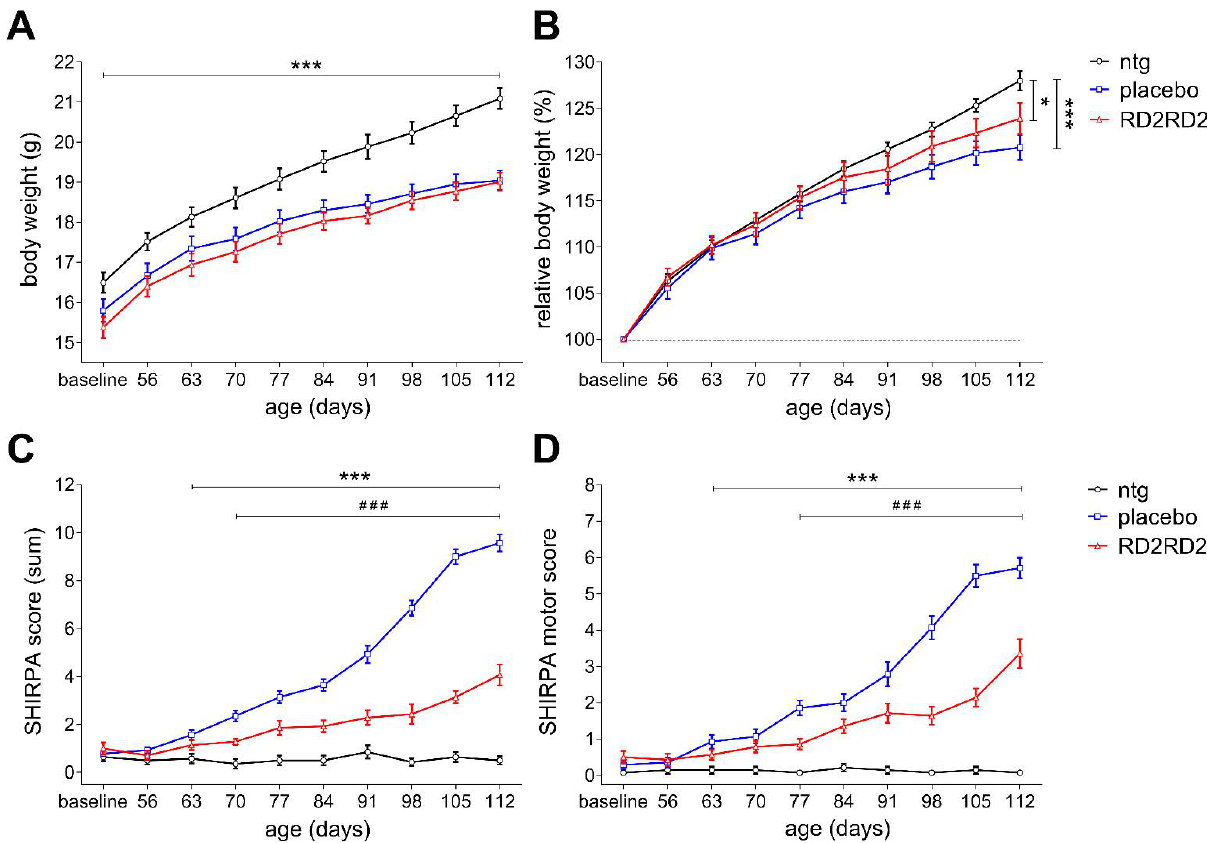
Figure 1. Development of body weight and phenotype in the oral treatment study. Changes in body weight of transgenic and non-transgenic (ntg) mice was analysed over time during treatment ( A , B ). Phenotype assessment was performed using the SHIRPA test battery ( C ). Subdivision of the SHIRPA parameters into a motor score revealed additional information of motor symptom progression in RD2RD2- vs. placebo-treated SOD1 G93A ( D ). Of note, the higher the score the worse the performance of the mice in the analyses in C and D. Data is represented as mean ± SEM. Statistical calculations were conducted by two-way RM ANOVA with Fisher’s LSD post hoc analysis, n = 14 each group ( A – D ). Results of analysis: ( A ) absolute body weight (g), F(2,351) = 10.76, p < 0.001, Fisher LSD post hoc analysis, ntg vs. placebo p < 0.001, ntg vs. RD2RD2 p < 0.001; ( B ) relative body weight (%), F(18,351) = 3.84, p < 0.001, Fisher LSD post hoc analysis, ntg vs.